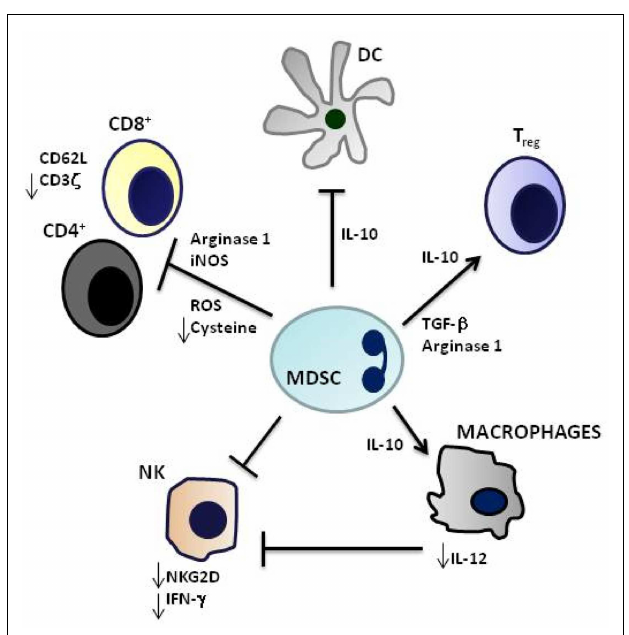
FIGURE 1 | Immunosuppressive mechanisms mediated by myeloid-derived suppressor cells . CD4 + and CD8 + T cell activation is inhibited by Arginase 1, inducible nitric oxide synthase (iNOS), generation of reactive oxygen species (ROS) and cysteine deprivation, and induction ofT regulatory cells (Treg) by IL-10 andTransforming-growth-Factor-beta (TGF- β ). Innate immunity is suppressed by downregulation of dendritic cell (DC) and macrophage production of IL-12 and by inhibition of Natural Killer (NK) cell cytotoxicity. Myeloid-derived suppressor cells (MDSCs) are highly producers of IL-10 that inducesTreg andTh2 cells and inhibits IL-12